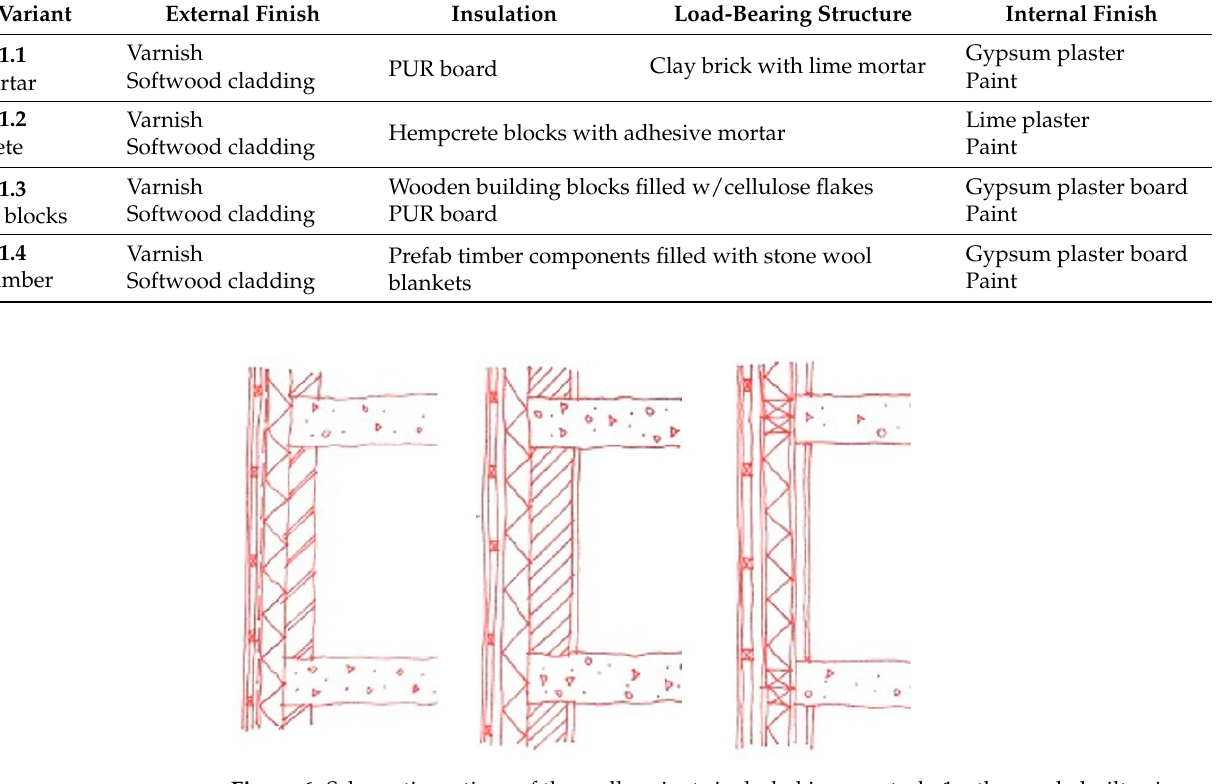
Figure 6. Schematic sections of the wall variants included in case study 1—the newly built primary school. On the left, variant 1.1 (clay masonry with lime mortar); in the middle variants 1.2 and 1.3 (alternative masonry with hempcrete and wooden blocks, respectively); and on the right variant 1.4 (prefab timber components). Source: Stijn Elsen, VUB Architectural Engineering [56].